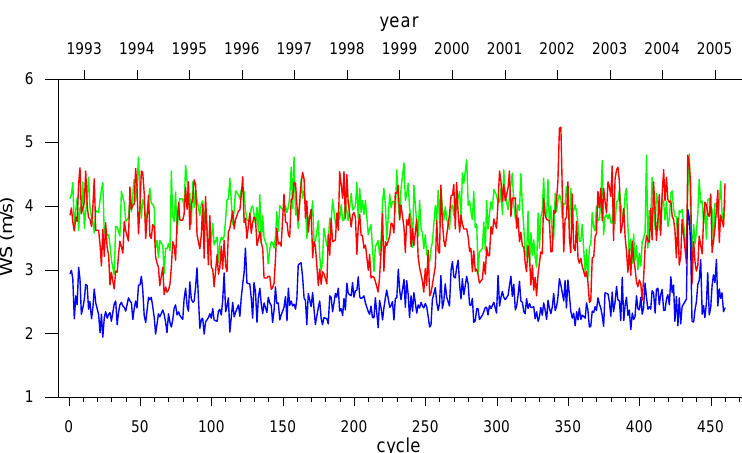
Figure 14b – WS standard deviation ( σ ). blue - Tropical; red : Sub-Tropical; green: Sub-Arctic. The regional dependence of the SSB does not only influence sea level variations. Dong